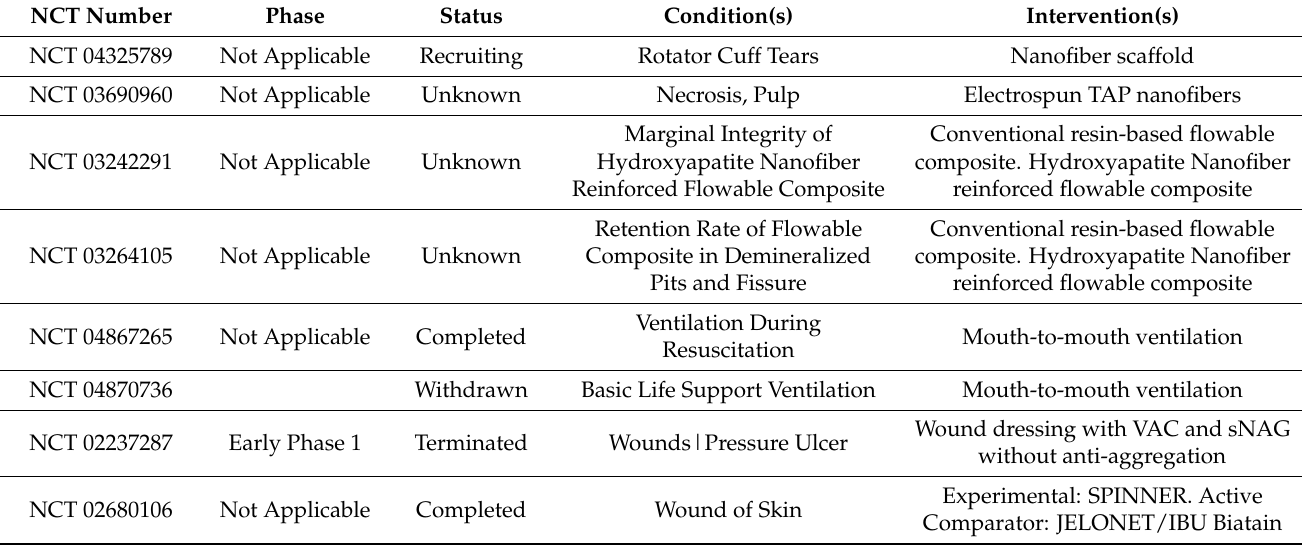
Table 6. A summary of the registered clinical trials using the term “nanofiber.” Data was collected from the clicaltrial.gov database based on a search performed on the 27 June